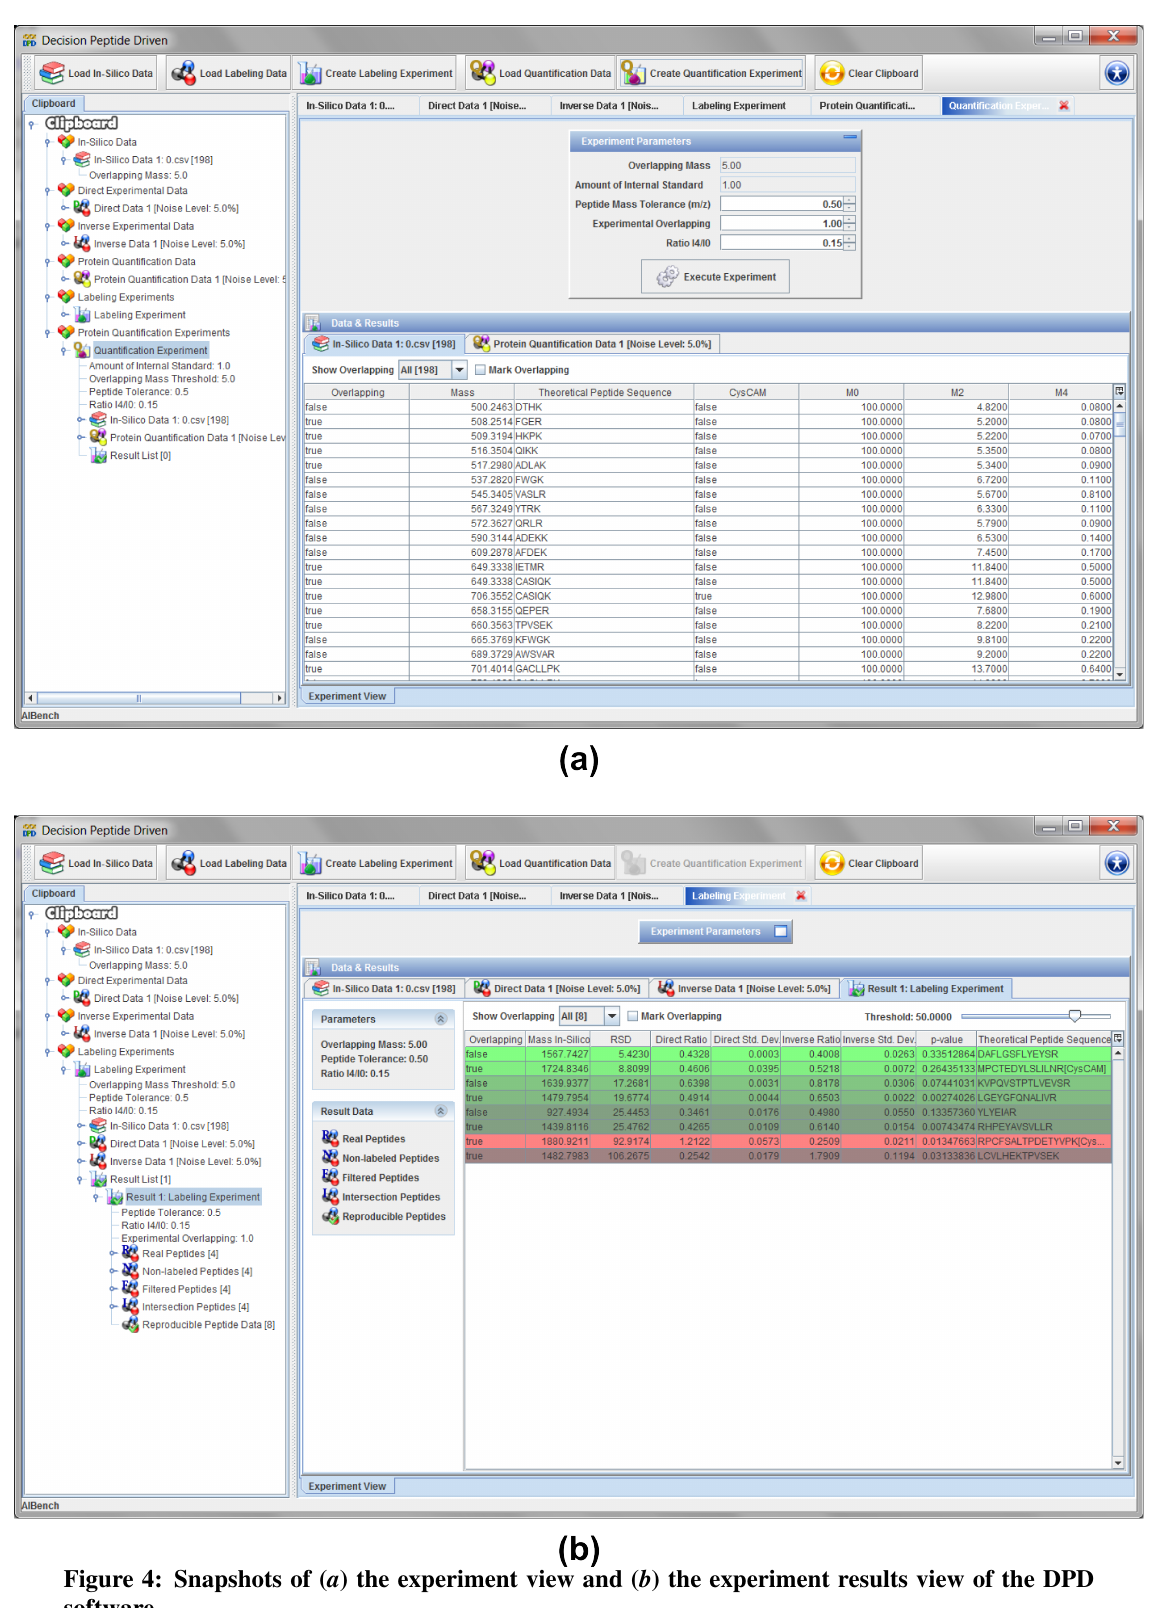
Figure 4: Snapshots of ( a ) the experiment view and ( b ) the experiment results view of the DPD